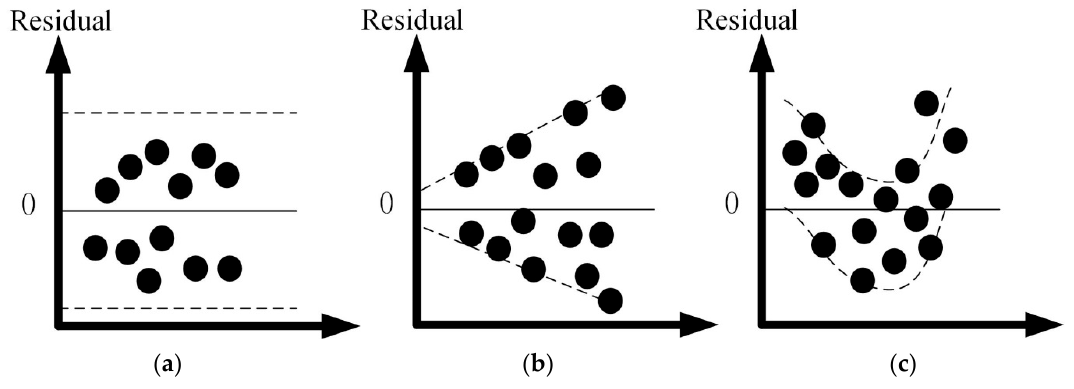
Figure 3. Residual plot analyses: ( a , b ) nonconstant residuals, and ( c ) unsuitable model.